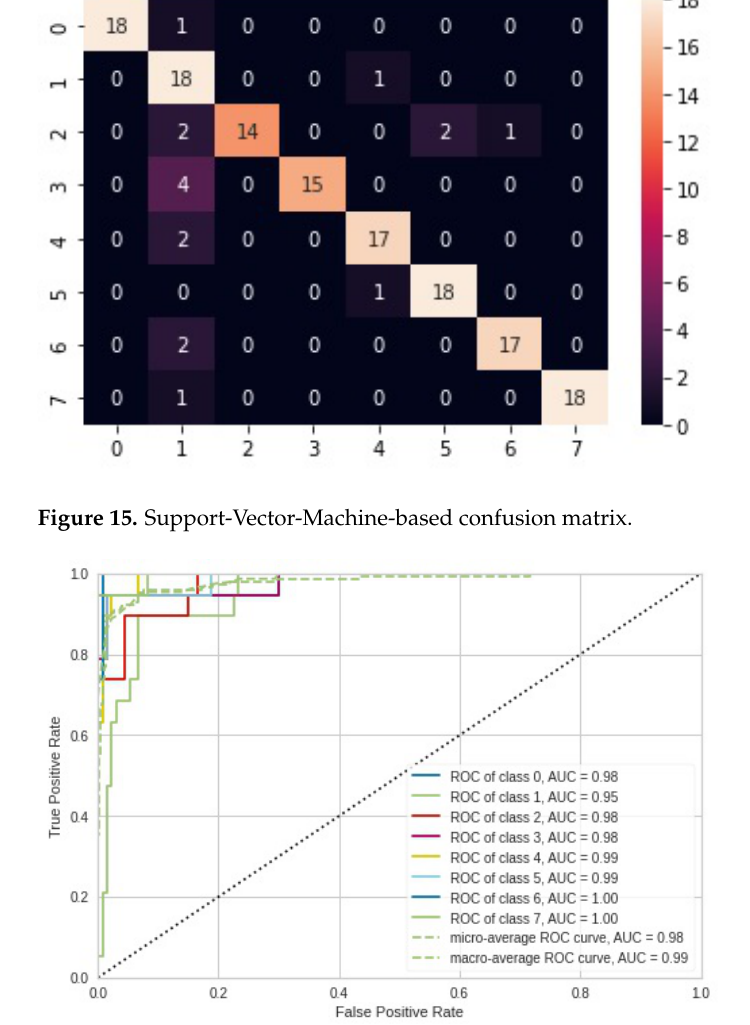
Figure 16. ROC AUC Curves for Support-Vector-Machine-based